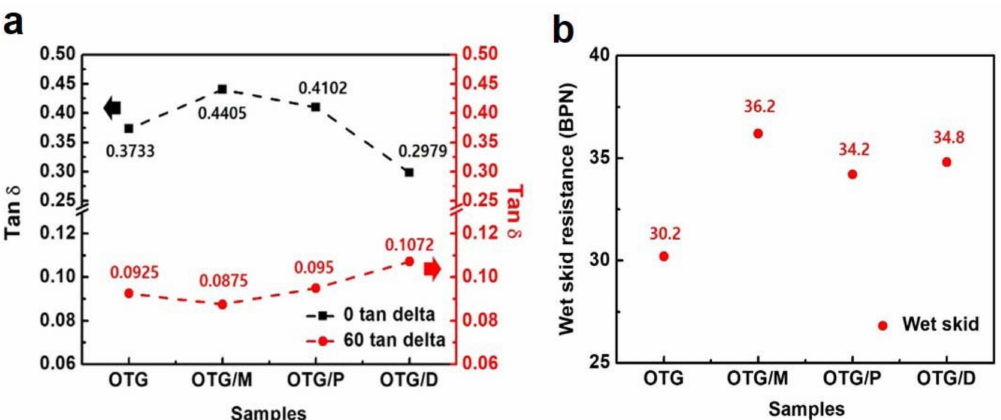
Figure 5. Dynamic properties of elastomer composites. ( a ) Tan δ of the elastomer composites with hybrid oils. ( b ) Wet skid resistance of the elastomer composites with hybrid oils.